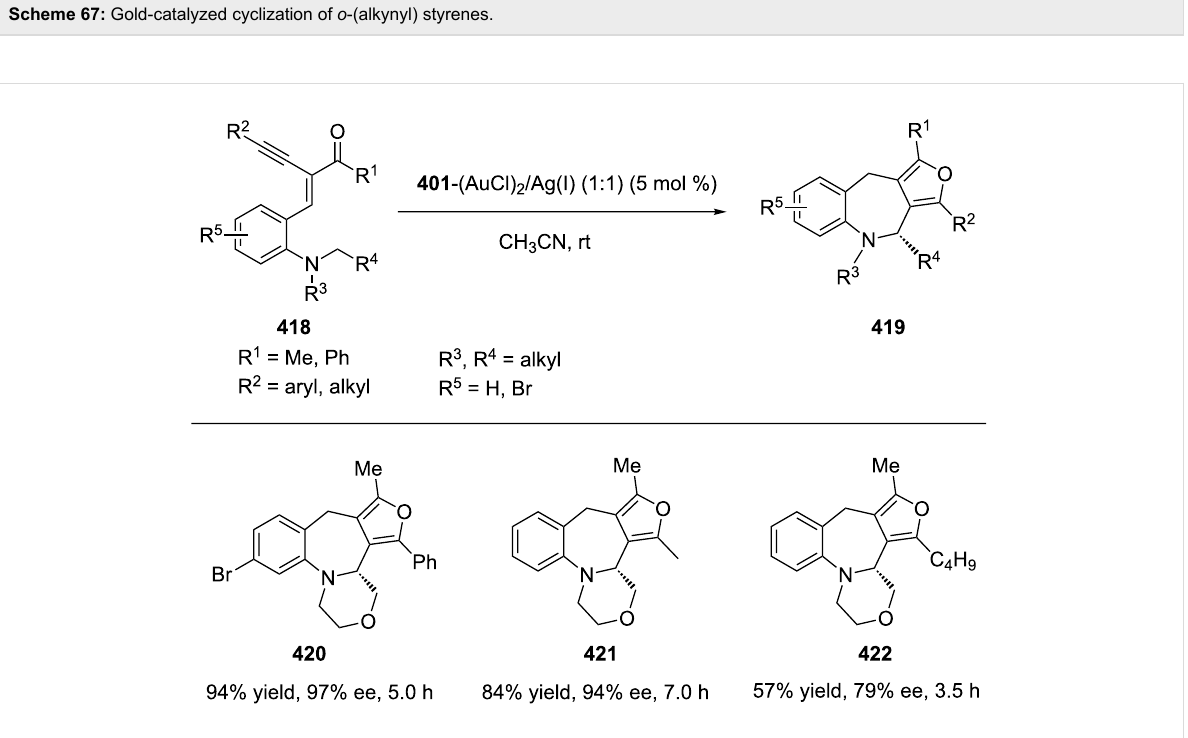
Scheme 68: Asymmetric gold(I)-catalyzed redox-neutral domino reactions of enynes.